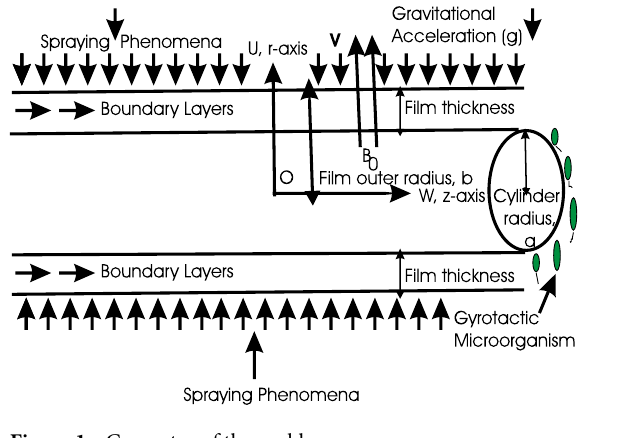
Figure 1. Geometry of the